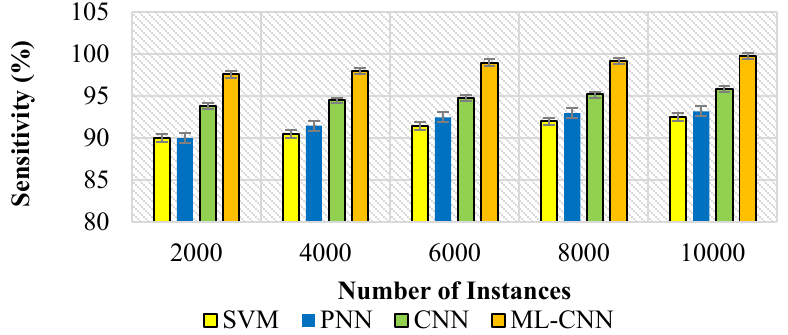
Figure 8. Sensitivity vs. number of instances .